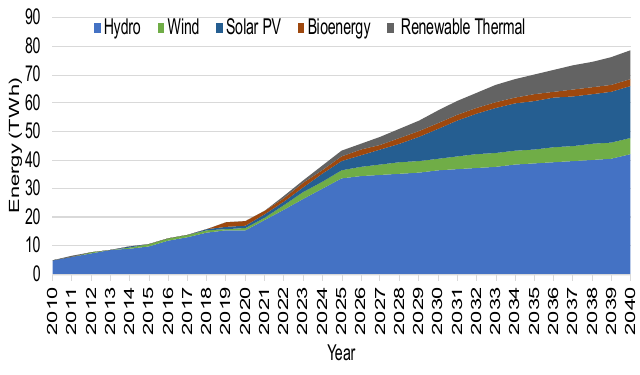
Figure 4. Annual forecasted generation